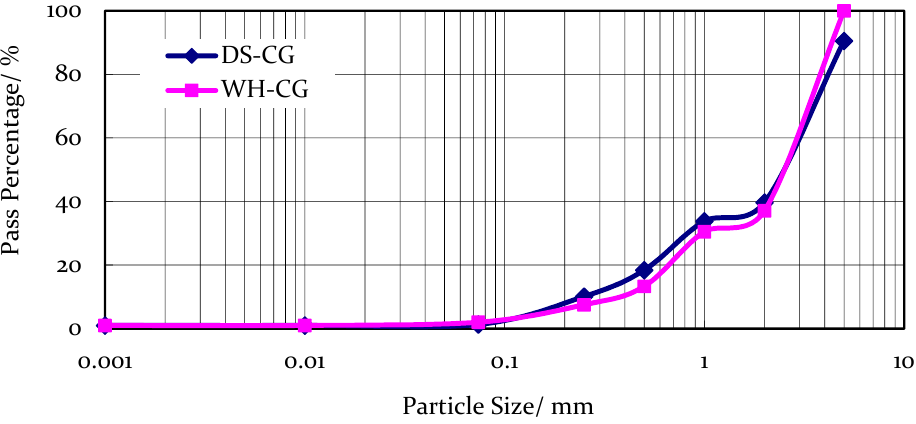
Figure 2. Gradation curves of CG samples.